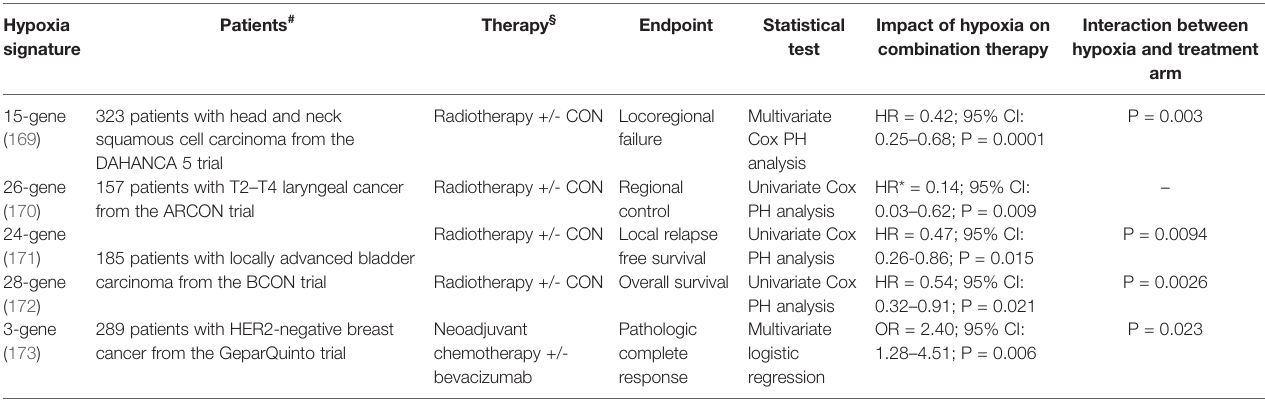
TABLE 1 | Predictive hypoxia gene signatures.